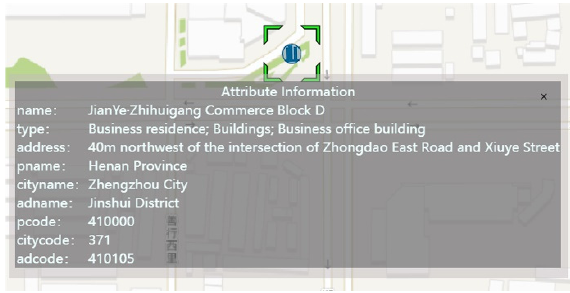
Figure 9. Attribute Information Query.